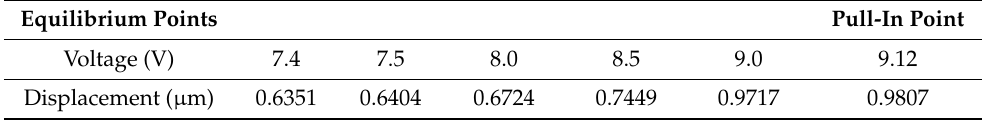
Table 3. Displacement value according to voltage.